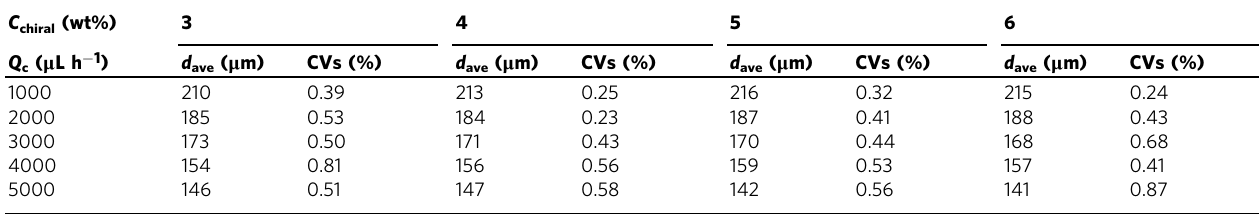
Table 1 Flow rate dependence of the average diameter (d ave ) of the monodispersed FCLC microdroplets. C chiral